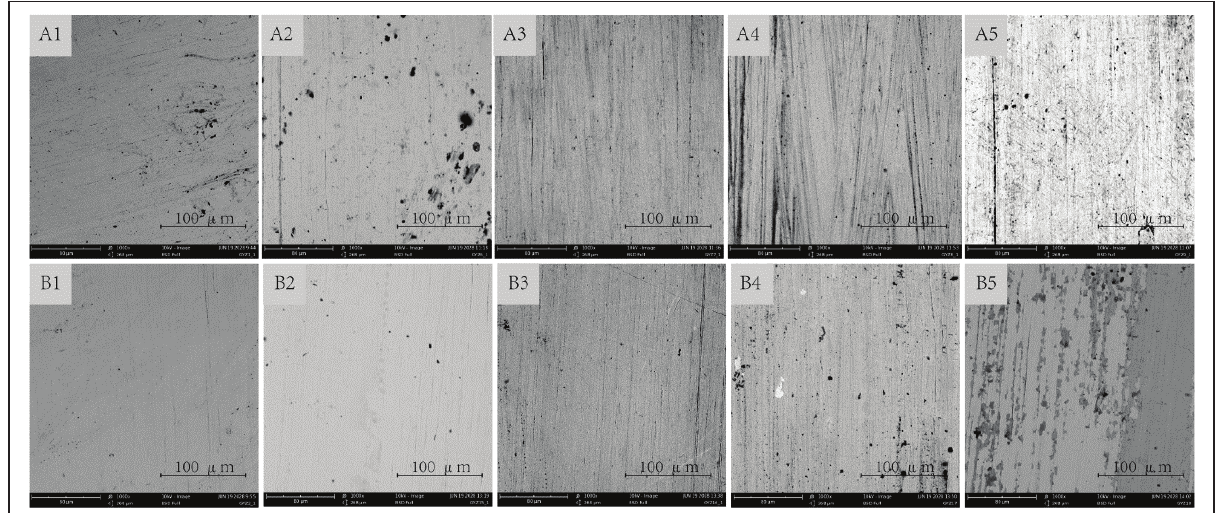
Figure 1. SEM images of unheated SS wire specimens and heated specimens. (A1-A5) Unheated 0.017 × 0.025 inch SS wire specimens and specimens Fig. 1. heated at power settings of 2, 4, 6, and 8 for eight seconds. (B1-B5) Unheated 0.019 × 0.025 inch SS wire specimens and specimens heated at power settings of 2, 4, 6, and 8 for eight seconds.